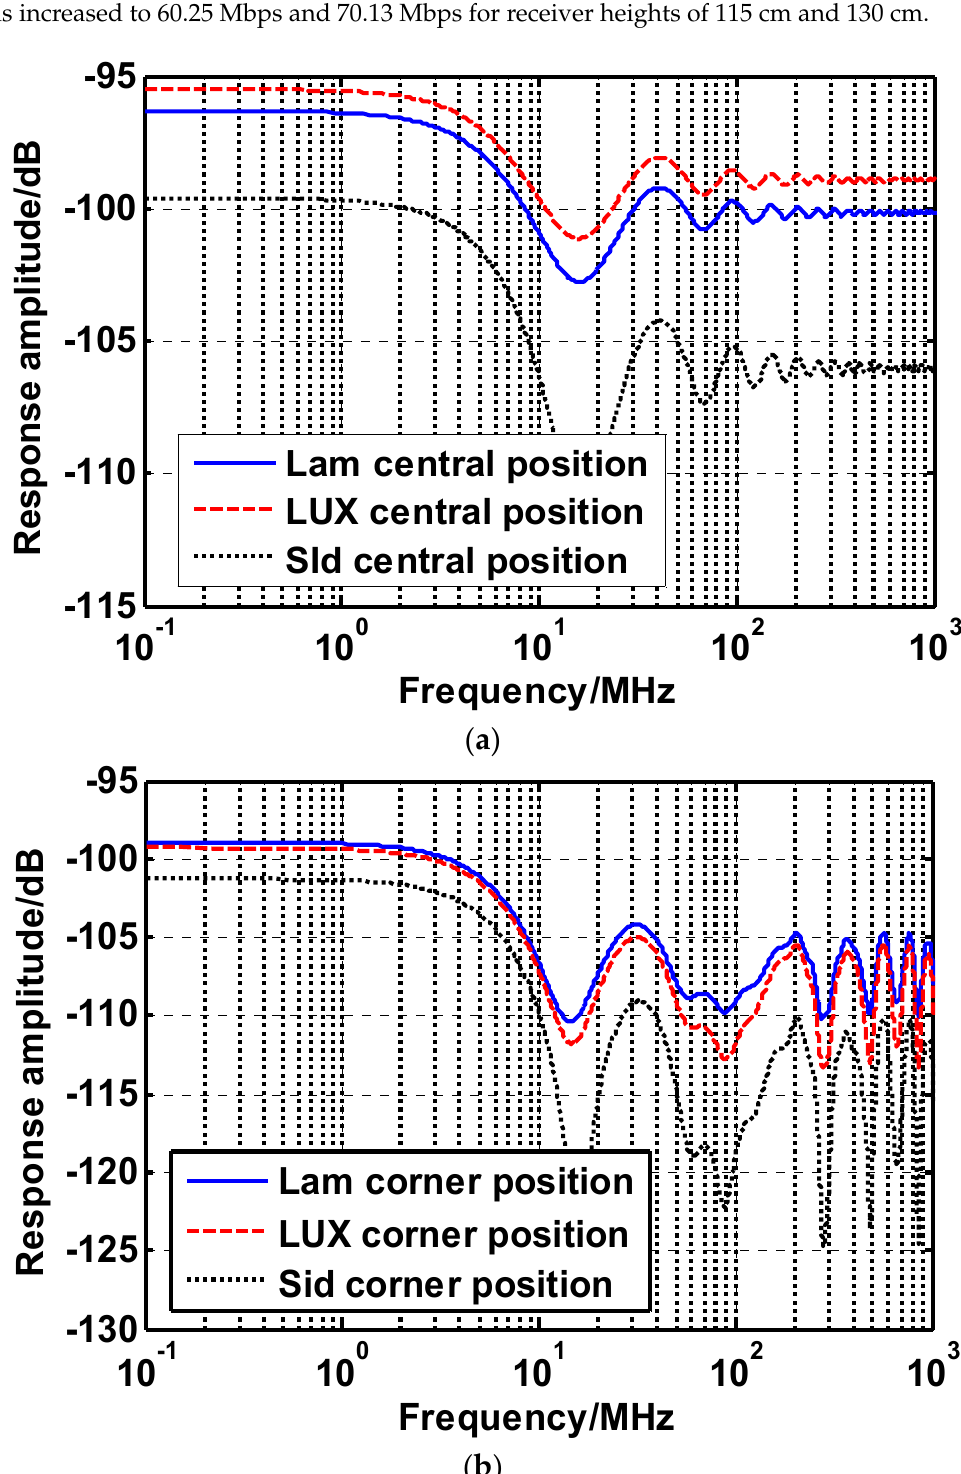
Figure 5. Frequency response curves of ( a ) central receiver position; and ( b ) corner receiver posi- tion.